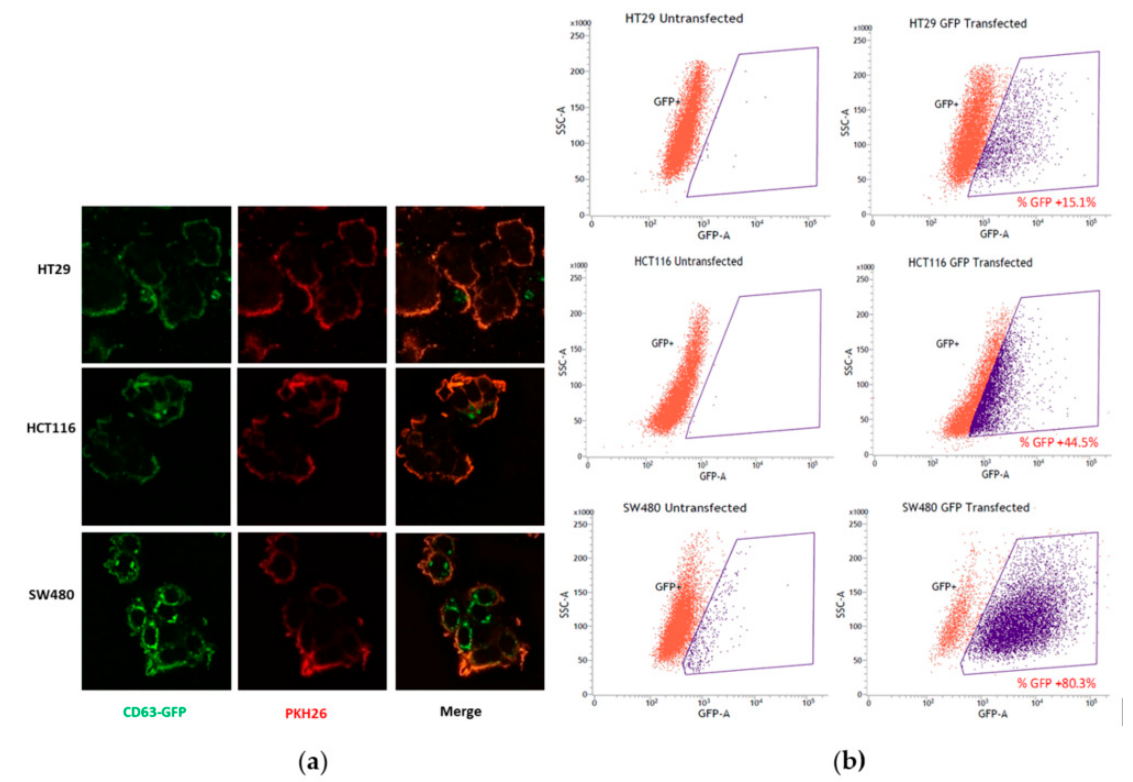
Figure 1. Expression of CD63-GFP in colon cancer cell lines. ( a ) Confocal microscopy; ( b ) Flow cytometric analysis.